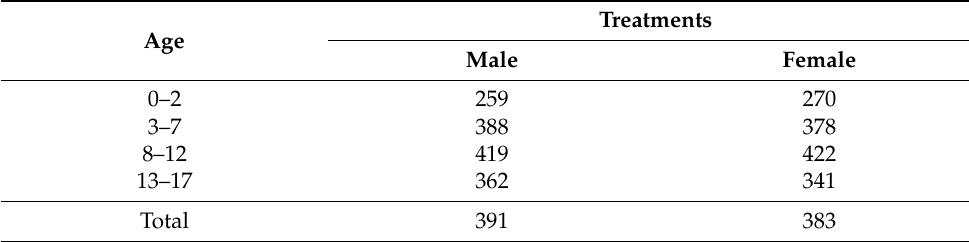
Table 7. Annual therapies of ASD per person per age and